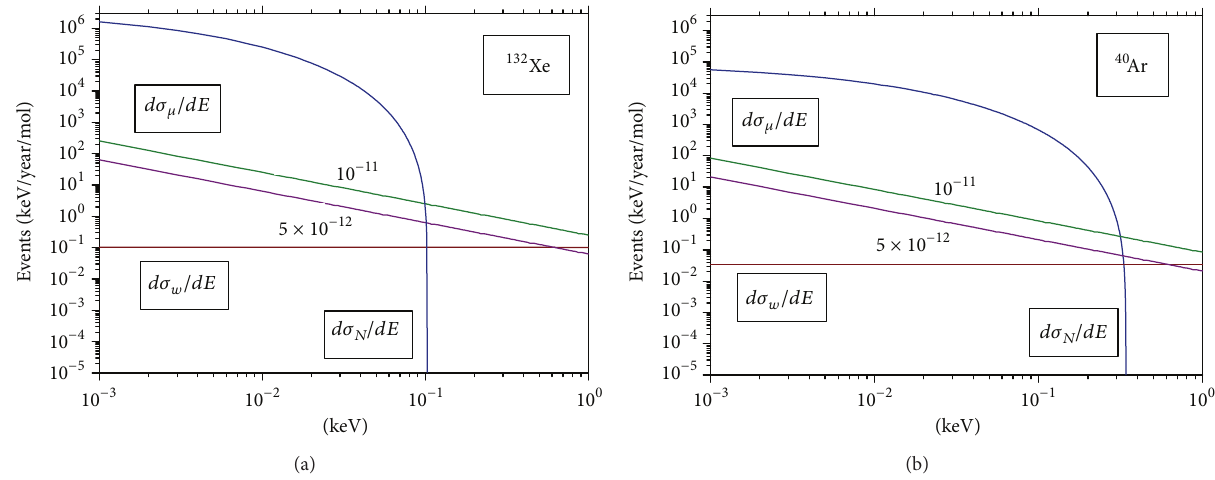
Figure 3: The count rates in xenon (a) and argon (b) for coherent scattering on nuclei and from ] e − scattering at magnetic moment 5 ⋅ 10 −12 𝜇 𝐵 and 10 −11 𝜇 𝐵